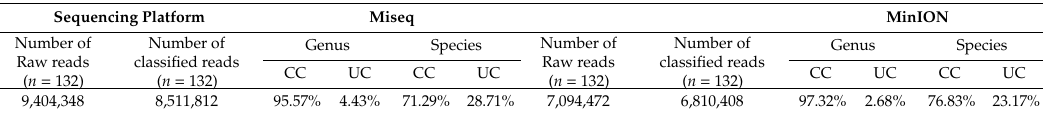
Table 2. Identified results of short-read amplicons or long-read sequencing with corresponding database for taxonomic assignment at genus or species